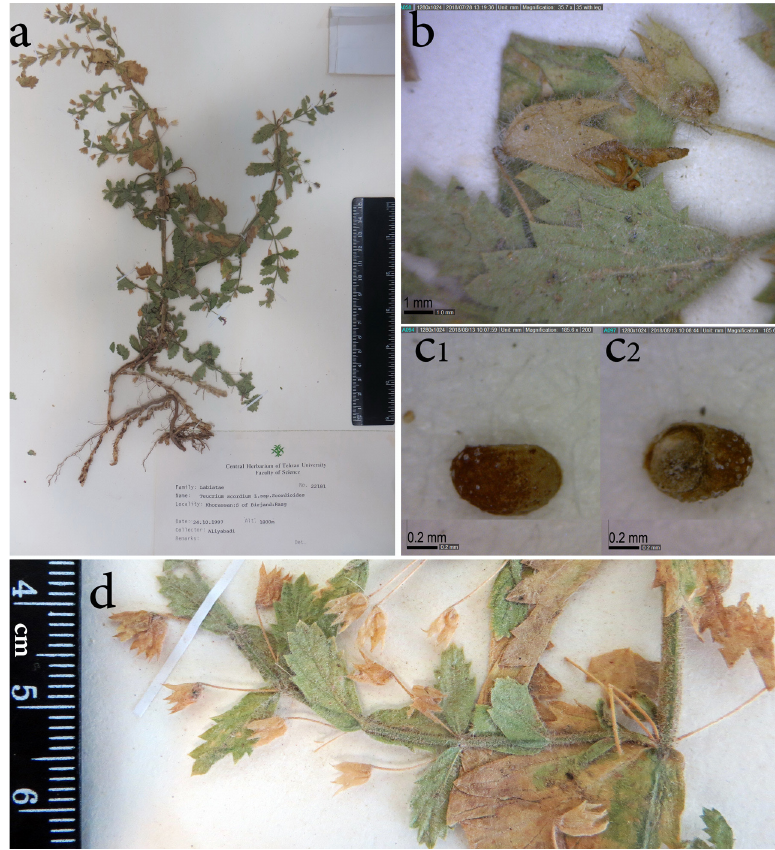
Figure 2. Teucrium scordium subsp. Scordioides. a) Herbarium specimen (TUH), b) Flower after the